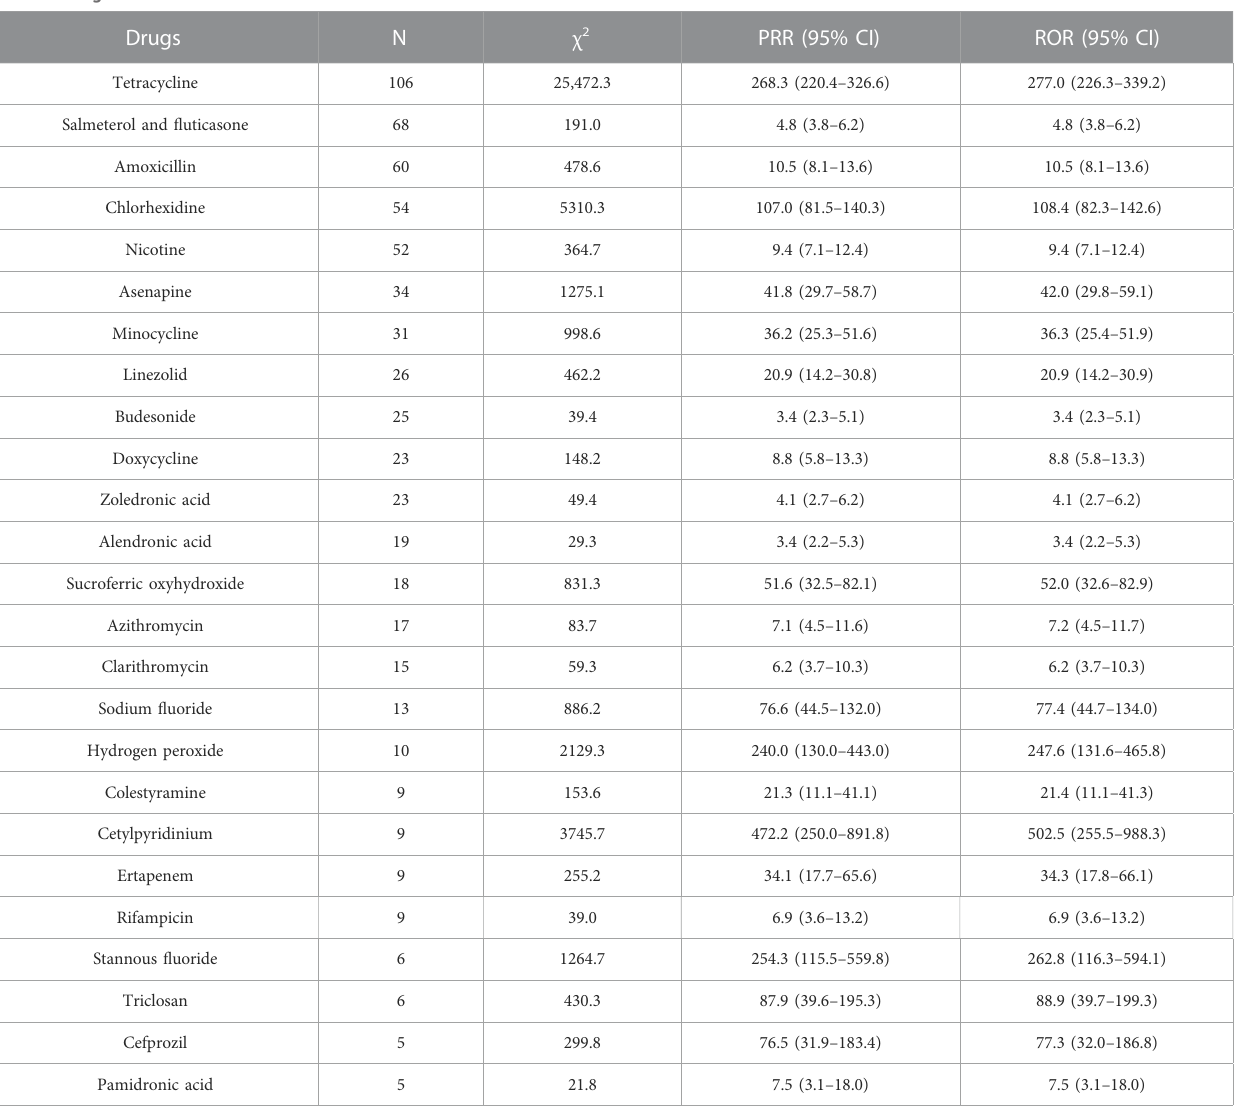
TABLE 3 Drugs associated with tooth discoloration based on the